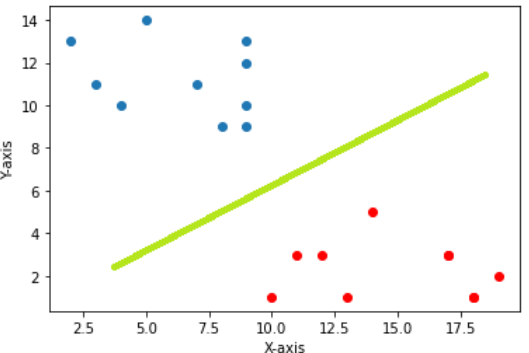
Figure 6. Support vector machine hyperplane [33].